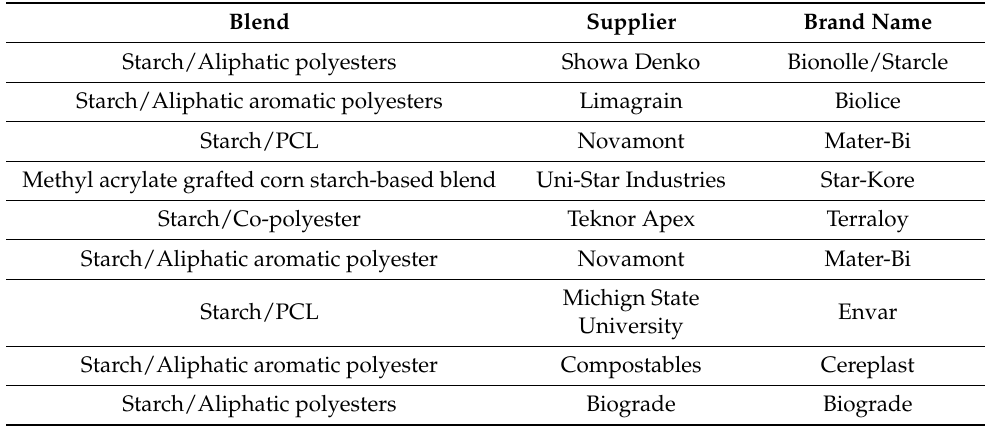
Table 11. Commercially available starch-based blends available for packaging